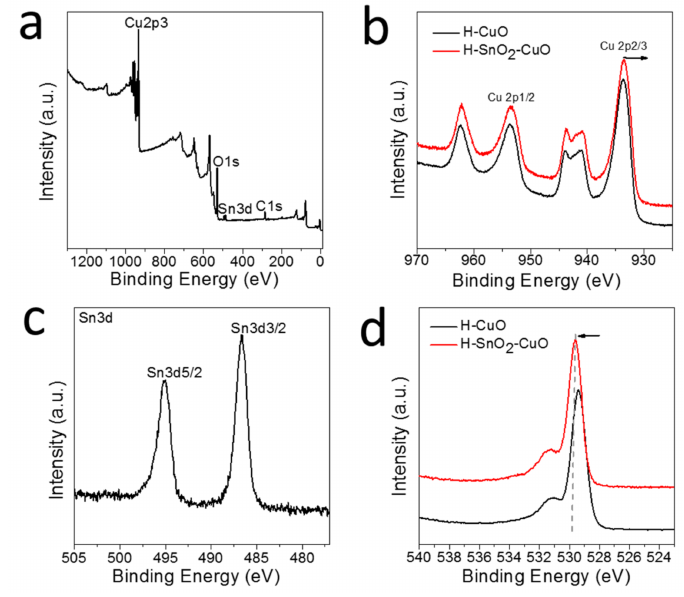
Figure 4. XPS spectra of H-CuO and H-SnO 2 -CuO: ( a ) the survey spectrum; ( b ) Cu 2p spectrum; ( c ) Sn 3d spectrum; and ( d ) O 1s